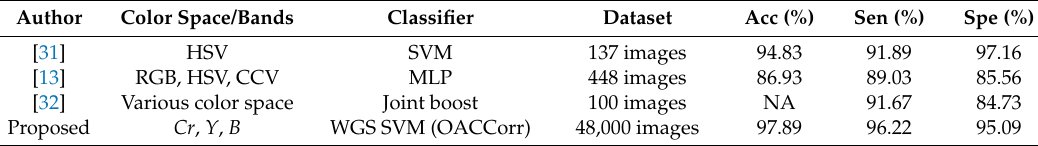
Figure 4. Performance of the proposed method. Table 3. Comparison of performance with other author work.